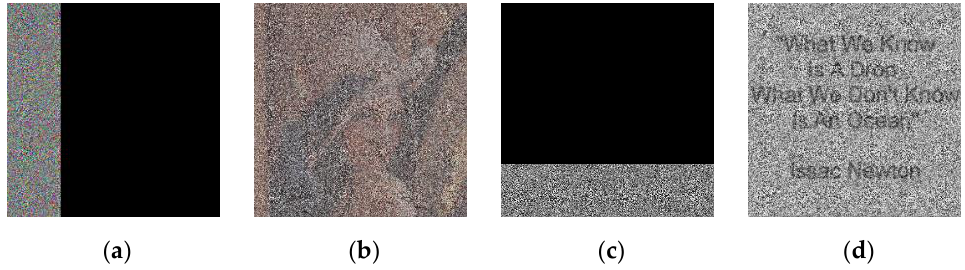
Figure 10. ( a ) Lena_encrypted.jpeg with 75% occlusion in different zones, ( b ) Decryption of Lena_encrypted.jpeg after 75% occlusion attack, ( c ) Message_encrypted.jpeg with 75% occlusion in different zones, ( d ) Decryption of Message_encrypted.jpeg after 75% occlusion attack.